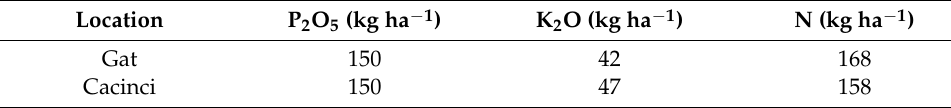
(Table 2). The optimal dose of mineral fertilizer was calculated using the ALRxp computer Table 2. Fertilization according to recommendation. program for fertilizer recommendations [32]. Table 2. Fertilization according to recommendation.